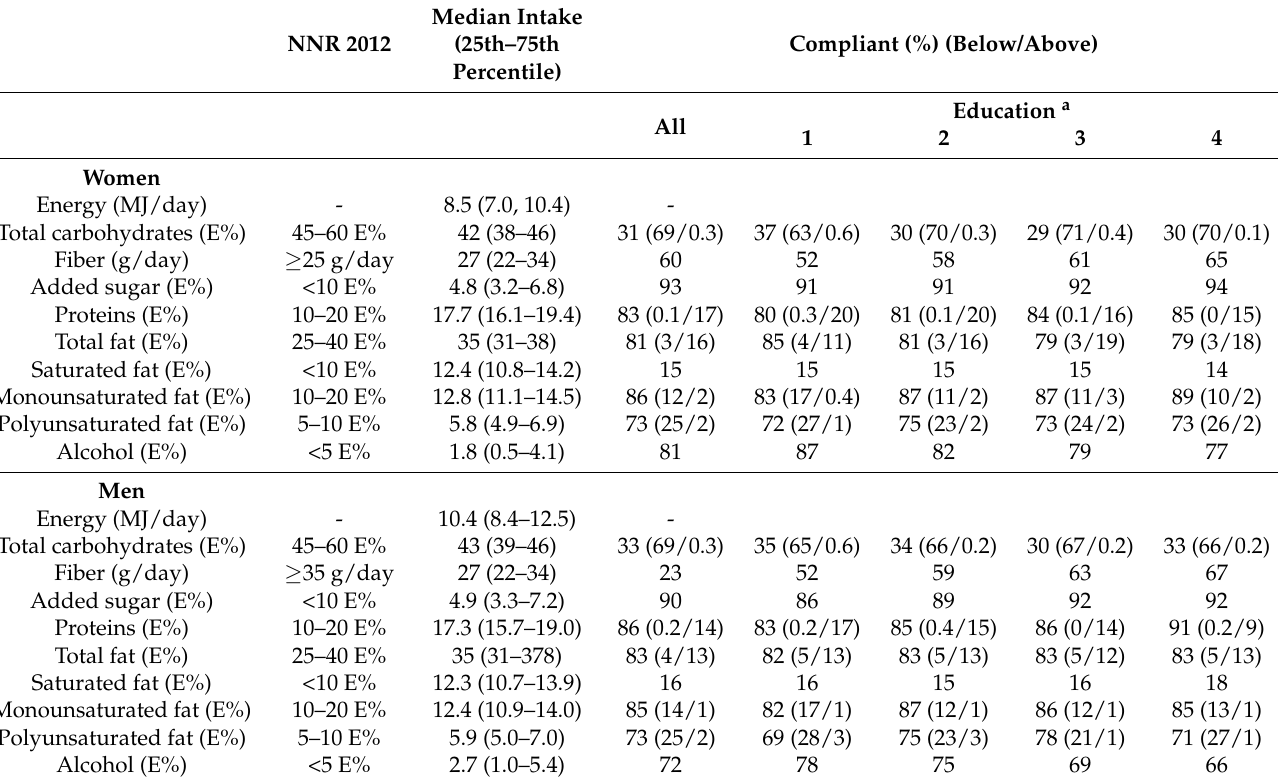
Table 2. Intake of energy and nutrients by sex and education level, and compliance with Nordic Nutrition Recommendations 2012. The Tromsø Study 2015–2016.